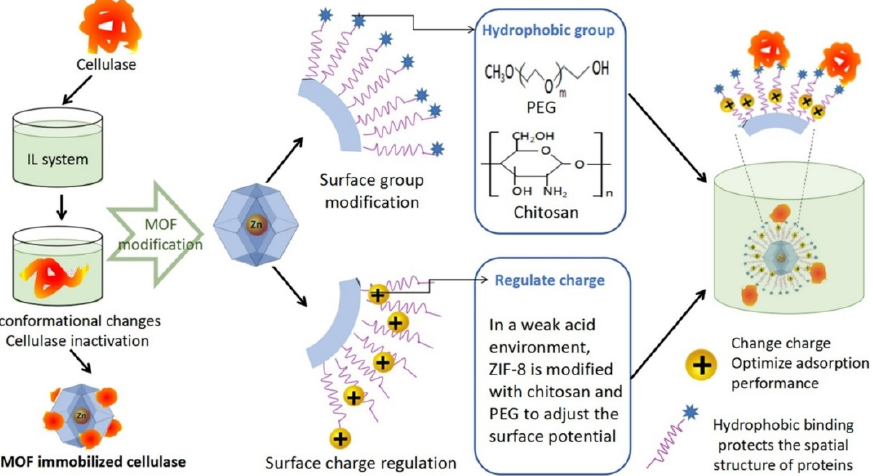
Figure 1. Functional modification of ZIF-8 (surface group modification/surface charge regulation) and its influence on immobilized cellulase (protects the spatial structure of proteins). Reproduced with permission from [45], Elsevier, 2021.